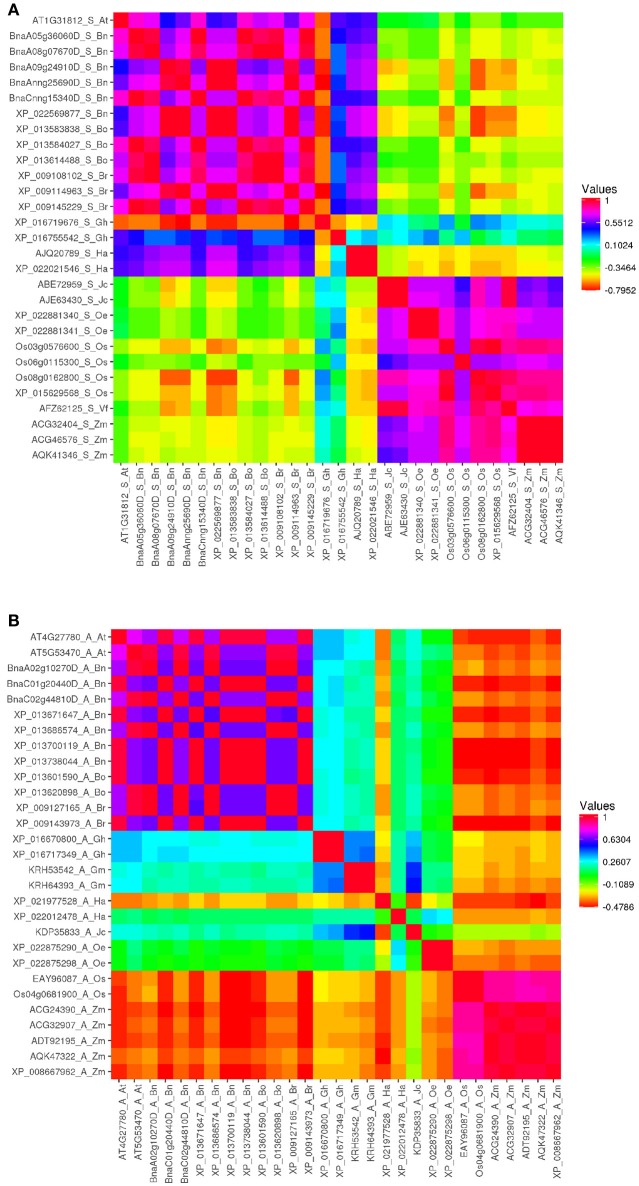
Heat map depicting amino acid sequence identity of oil crops ACBP. (A) Small ACBP, (B) Ankyrin repeats ACBP, large and kelch motifs ACBP are in Supplementary Figure 1. The map was generated by Heatmapper (Babicki et al., 2016), with Pearson's correlation matrix calculation. Color intensity change with distance value as indicated.